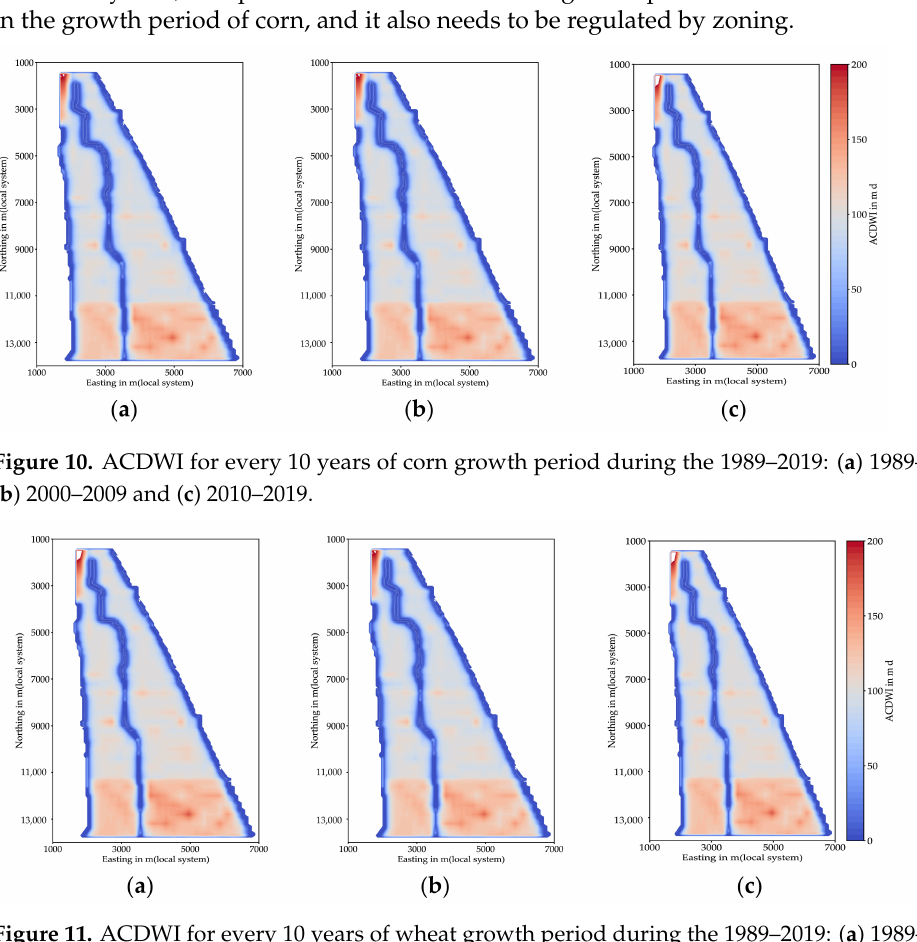
Figure 11. ACDWI for every 10 years of wheat growth period during the 1989–2019: ( a ) 1989–1999, ( b ) 2000–2009 and ( c ) 2010–2019. Table 7. Spatiotemporal ACDWI averages for all decades and sections, together with the respective precipitation